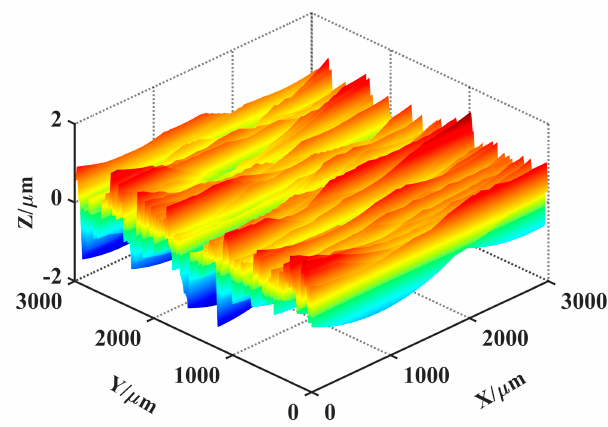
Figure 10. Theoretical topography under v w = 5 m/s and a p = 5 μ m.